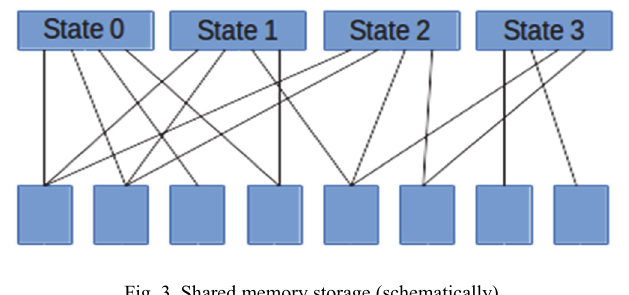
Fig. 3. Shared memory storage